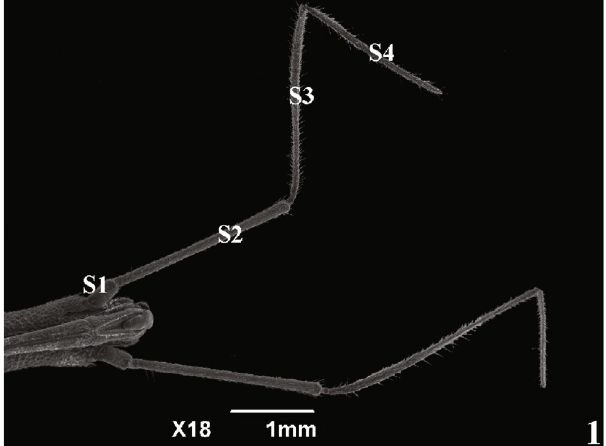
Figure 1: Scanning electron micrographs of the head of R. brethesi showing antennal segments. S1: fi rst segment (scape); S2: second segment (pedicel); S3: third segment ( fl agellomere I); S4: fourth segment ( fl agellomere